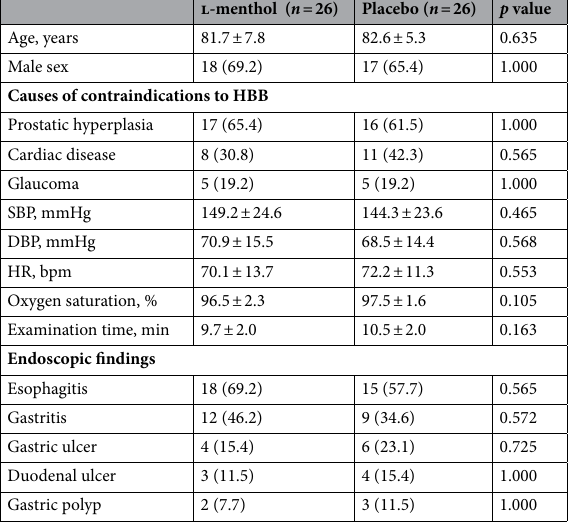
Table 1. Clinical characteristics of the two groups. Values are mean ± standard deviation or n (%). DBP diastolic blood pressure, HBB hyoscine- N -butylbromide, HR heart rate, SBP systolic blood pressure.